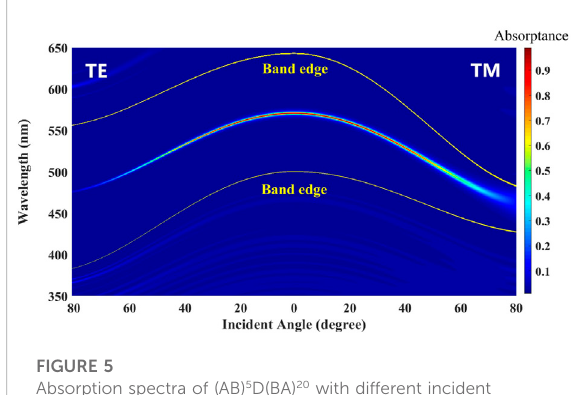
FIGURE 5 Absorption spectra of (AB) 5 D(BA) 20 with different incident angles for TE and TM polarizations. The yellow lines denote the variation trends of two band edges with the incident angles. All parameters are the same as those used in Figure 2B.